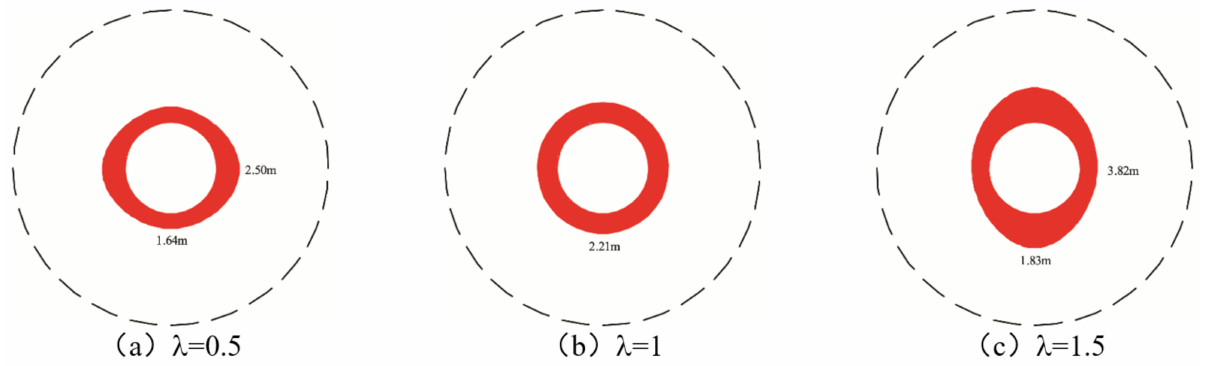
Figure 8. Range of extremely strong rockburst when σ v = 40 Mpa: ( a ) σ H / σ v = 0.5; ( b ) σ H / σ v = 1.0; ( c ) σ H / σ v = 1.5.